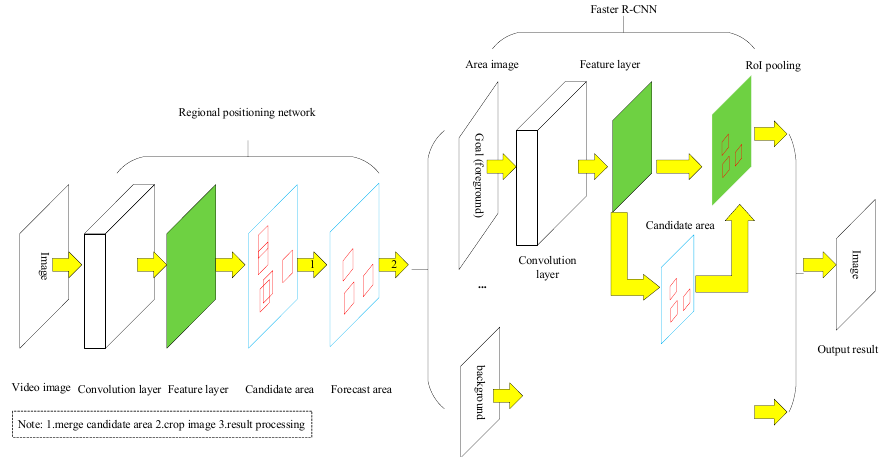
Figure 4. Scene Semantic Narrowing process.